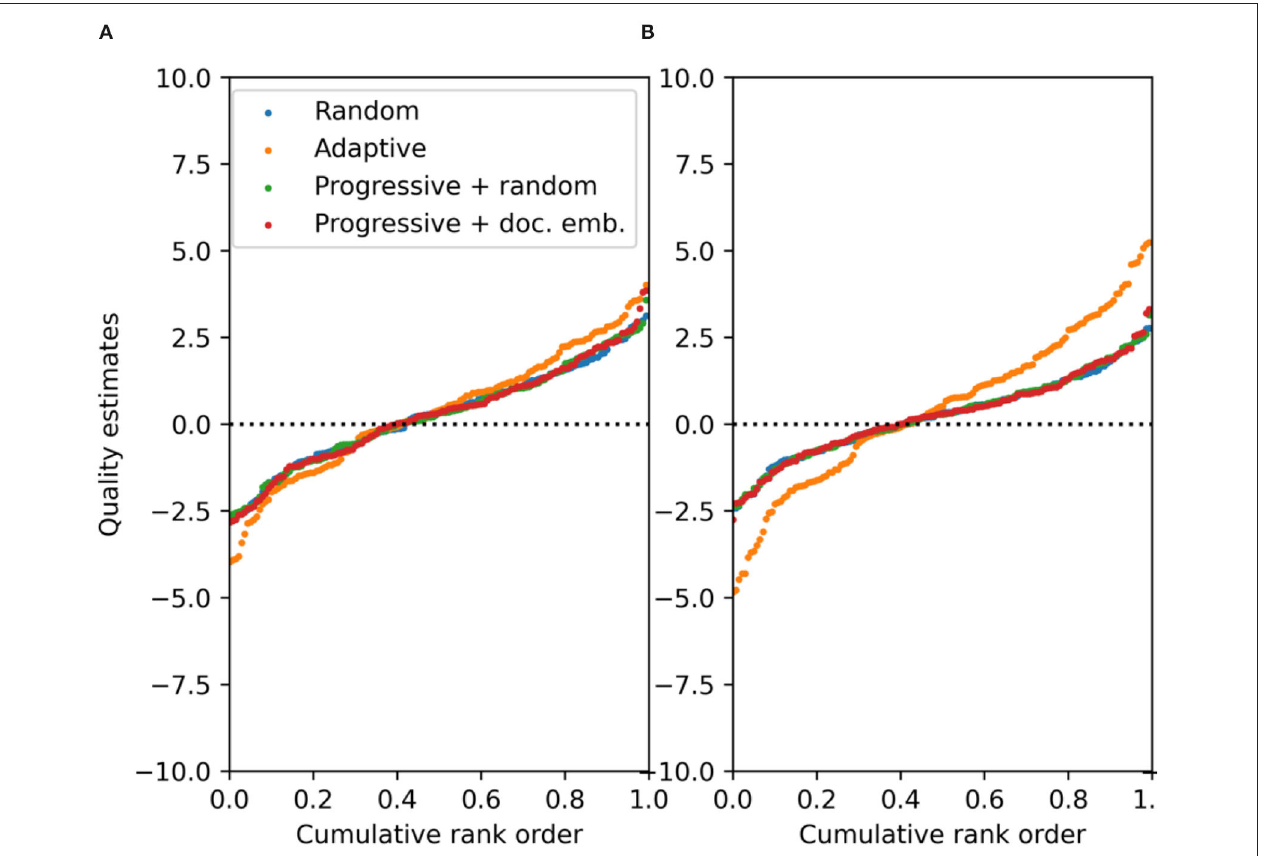
FIGURE 6 | For essay set 2 ( N 2 = 150), quality parameter estimates with respect to their cumulative ranking for 5 (A) and 10 (B) comparisons per work on average. This is assessed for different selection rules: random (CJ), adaptive (ACJ), and a progressive selection with a random component and with a similarity component using document embeddings (100